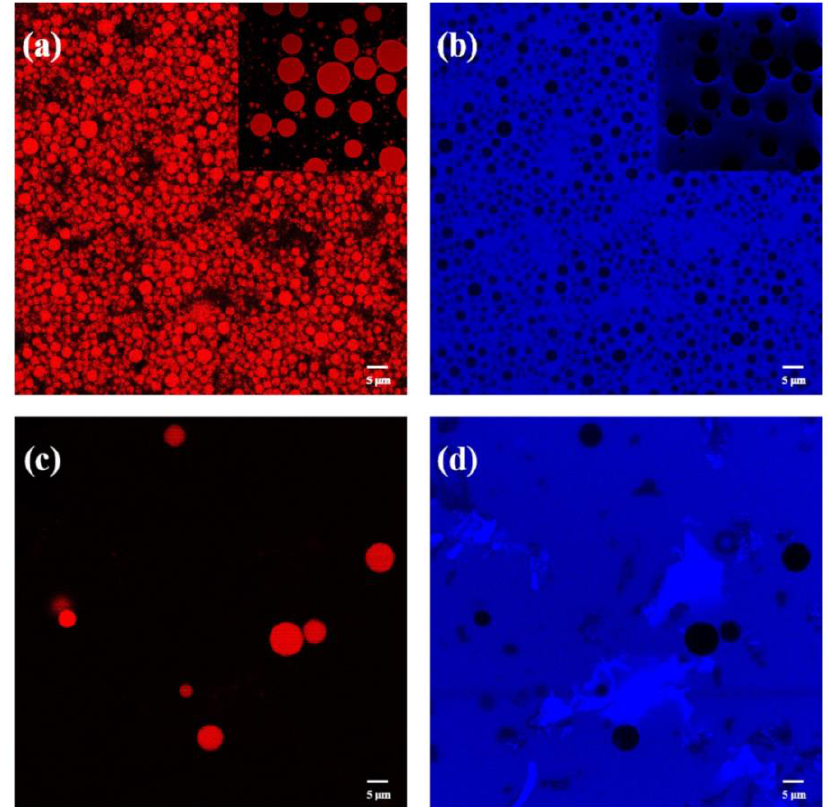
Figure 5. Confocal laser scanning microscopy images of fresh Pickering emulsion stabilized by 1.0 wt% TEMPO-oxidized ChNCs (T-ChNCs) ( a , b ) and chitin powder ( c , d ): MCT oil stained with the Nile red ( a , c ), T-ChNCs or chitin powder dyed by Calcofluor white strain ( b , d ). The volume fraction of MCT oil is 0.10. The scale bar is 5 μm.